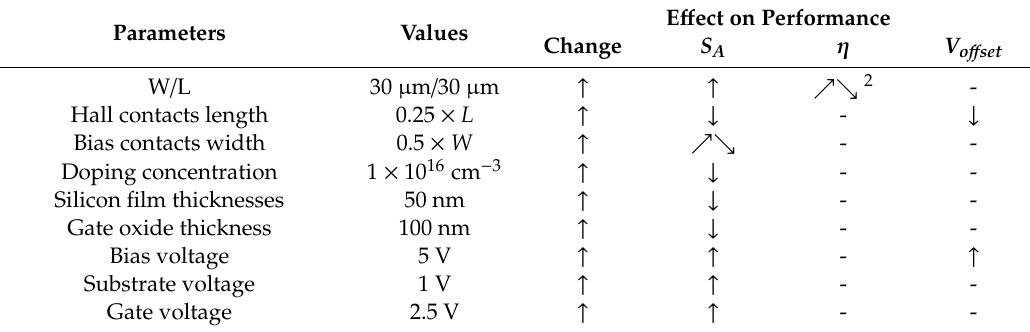
Table 2. Impacts of simulated Hall sensor parameters changes on performance 1